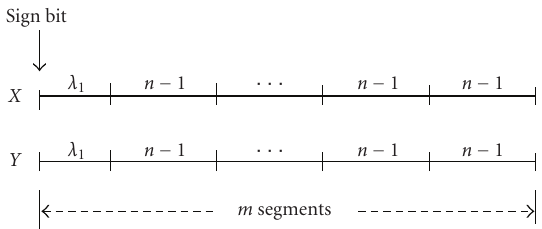
Figure 3: Decomposition based on the largest size of embedded